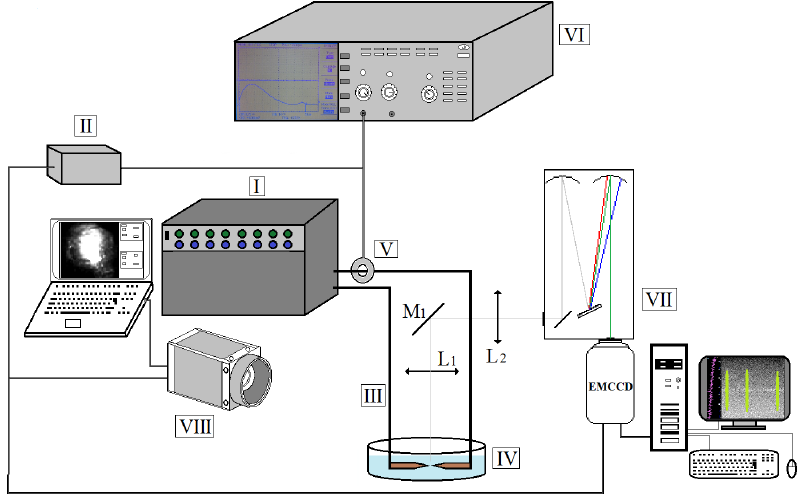
Figure 1. Experimental setup for the underwater arc discharge generation.